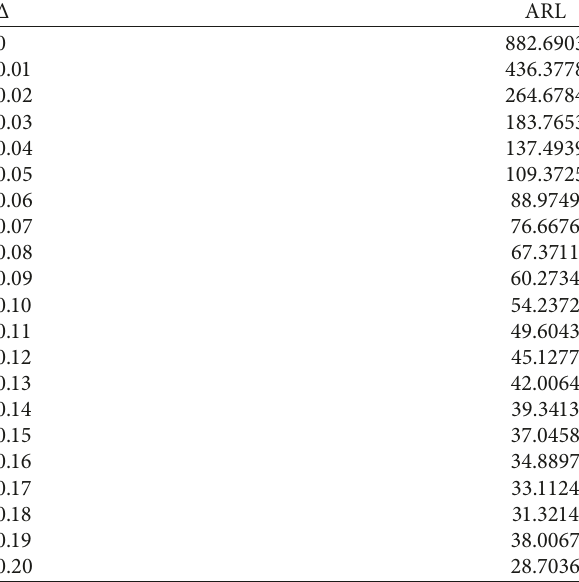
� 2, ϕ � 2, and h � 3. 1